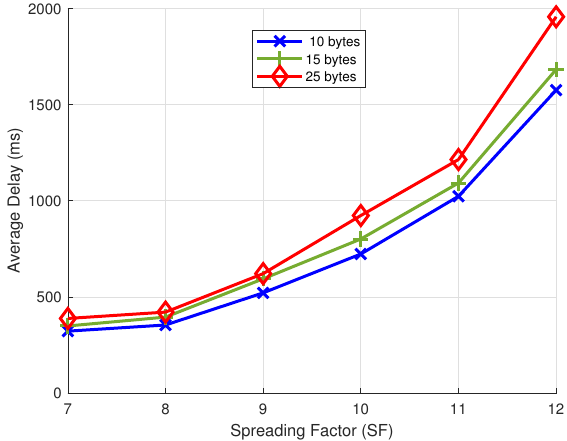
Figure 12. Average